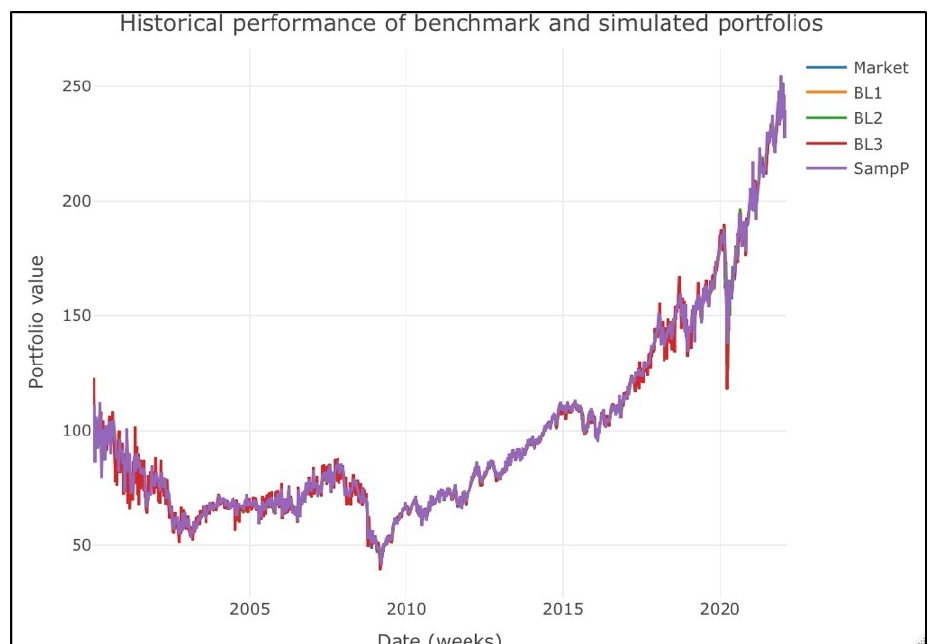
Figure 1. Historical performance of the simulated portfolios.